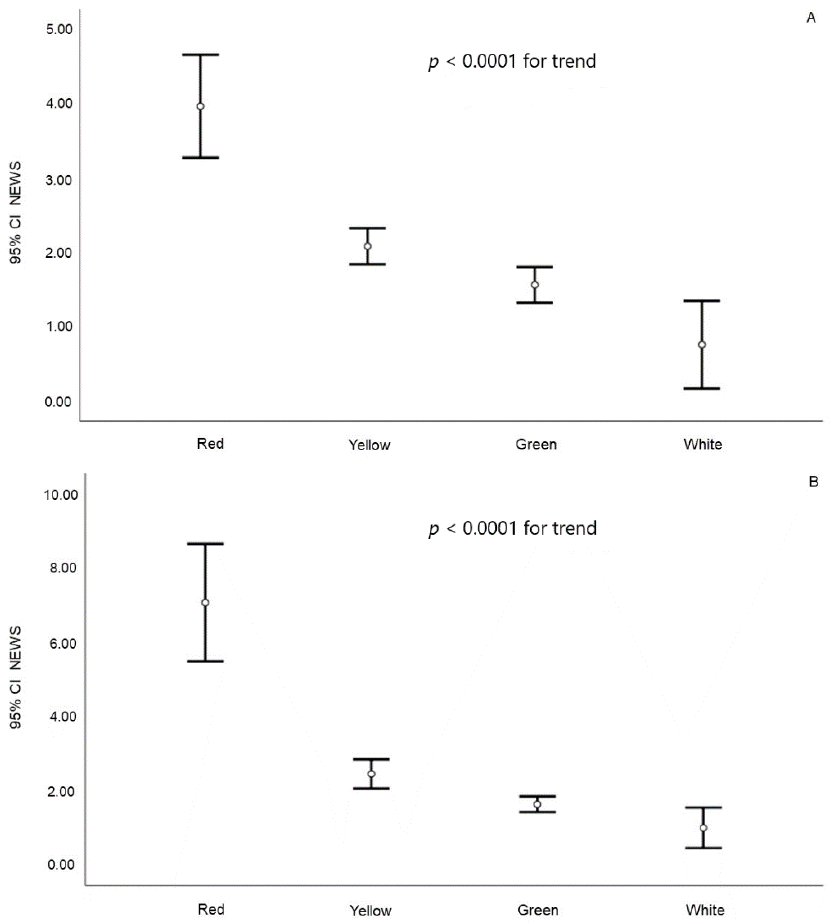
Figure 4. Relation between NEWS value and dispatch priority codes ( A ) and emergency department triage code ( B ).